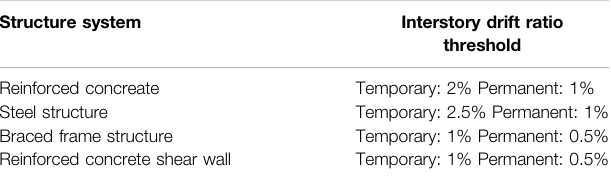
TABLE 2 | Threshold in the interstory drift ratio for various structures. Structure system